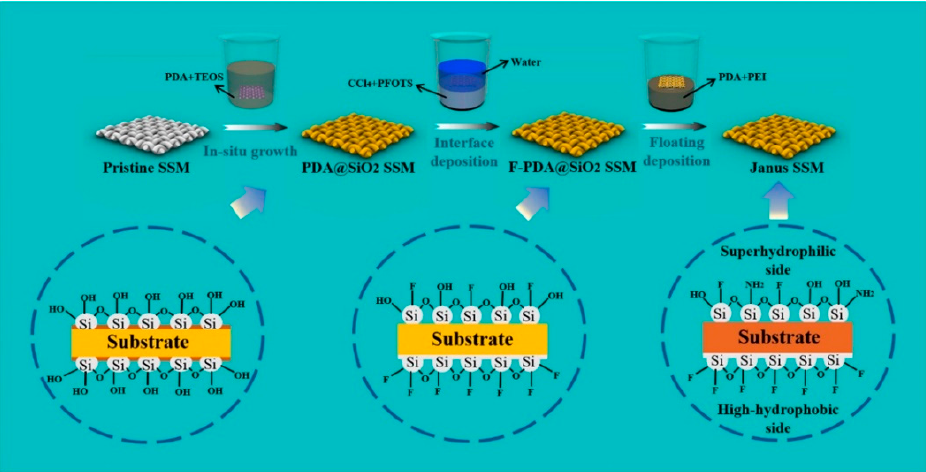
Figure 7. Schematic illustration of the preparation process of Janus SSM. Reprint with permission from Ref. [68] . Copyright 2022, Elsevier.